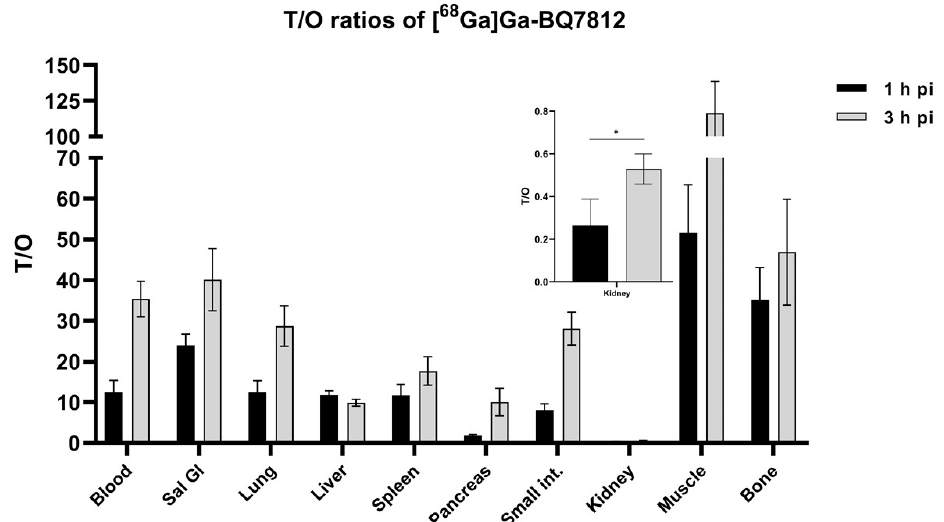
Figure 6. In vivo biodistribution of [ 68 Ga]Ga-BQ7812 in PC3-pip tumour-bearing mice at 1 and 3 h post-injection showing the Tumour-to-organ ratios (T/O). Statistical analysis was done using un- paired, two-tailed t -test. * Statistically significant ( p < 0.05) difference in tumor to kidney ratio.